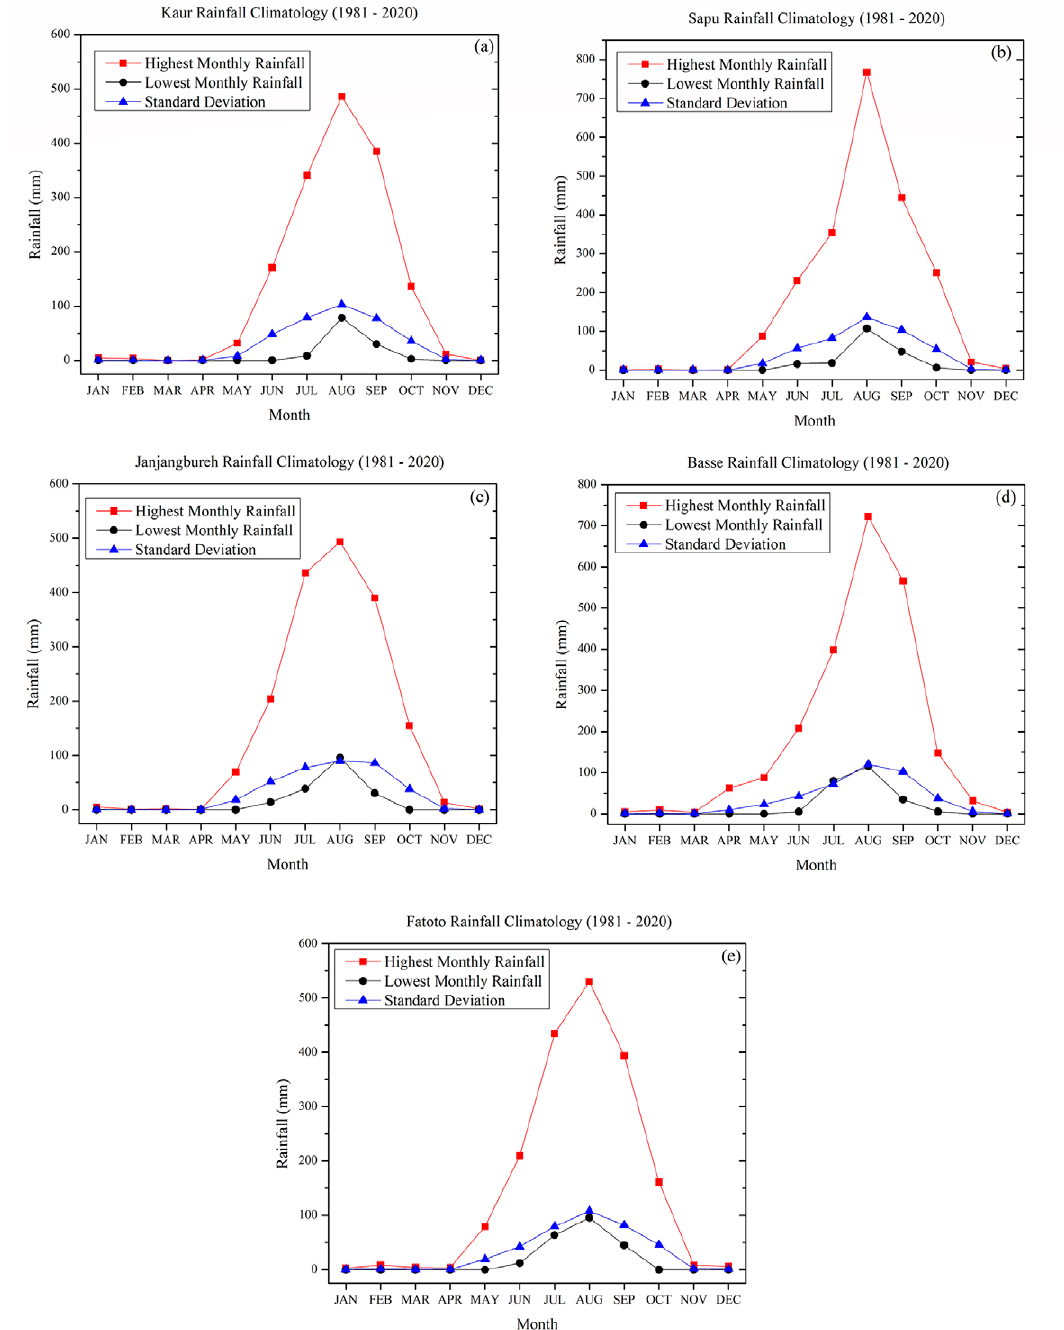
Figure 4. Rainfall variability at individual stations (Eastern